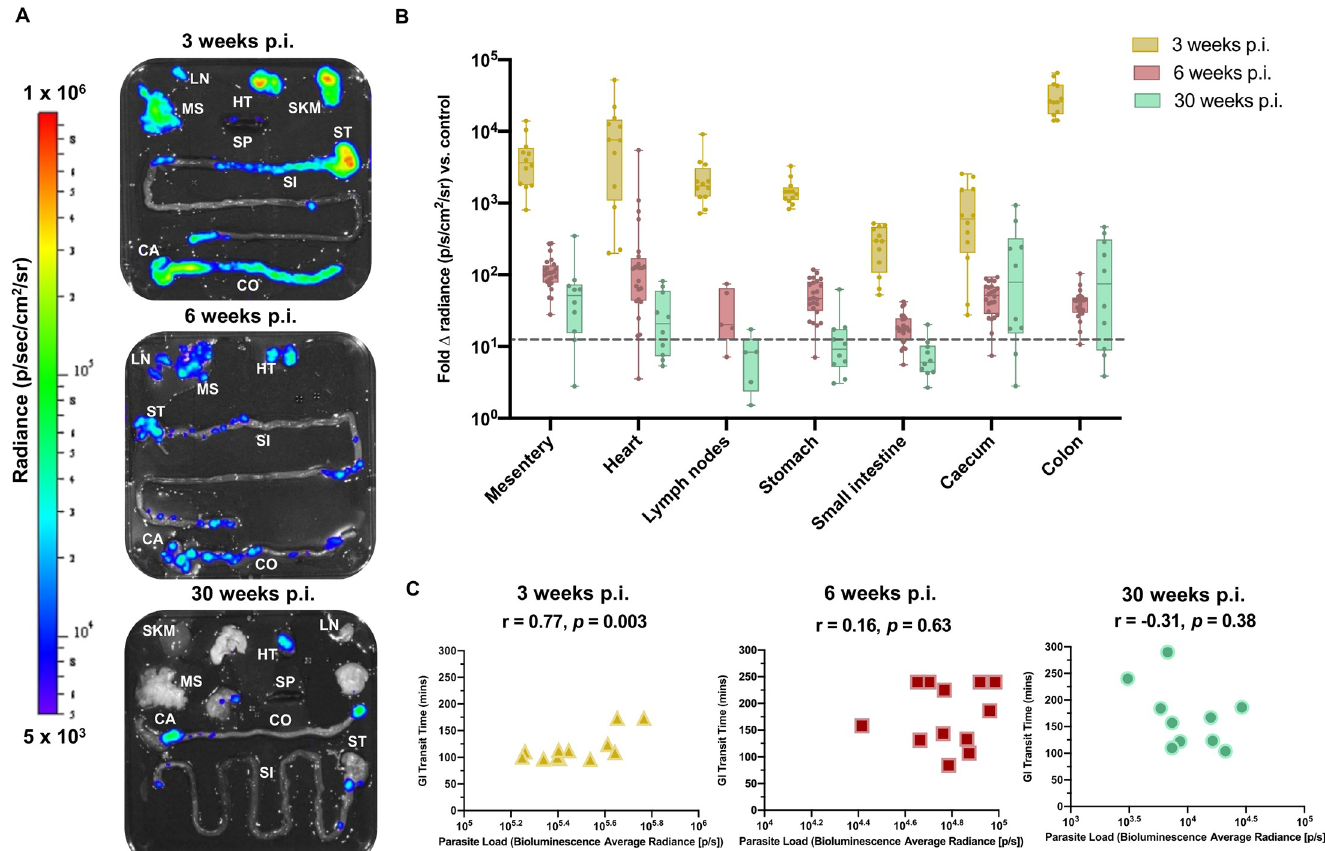
Fig 2. Tissue parasite distribution kinetics in TcI-JR-infected C3H/HeN mice. A. Representative images show parasite distribution in different organ tissue (lymph nodes—LN, gut mesenteric tissue—MS, heart—HT, spleen—SP, skeletal muscle—SKM, stomach—ST, small intestine—SI, caecum—CA and colon—CO) of a TcI-JR infected C3H mouse at 3, 6 and 30 weeks post-infection (p.i.) using ex vivo bioluminescence imaging. Overlaid log-scale pseudocolour heat maps are representative of bioluminescence intensity; the log-scale range is indicated in units of radiance. B. Box-plots show infection intensity of different organ tissue at 3 ( n = 12 per group), 6 ( n = 24 per group except n = 5 lymph nodes) and 30 ( n = 10 per group except n = 5 lymph nodes) weeks p.i. Data points are expressed as fold change in bioluminescence vs. na ï ve controls. Limit of detection is denoted as dashed line. The horizontal line within each box indicates median and the whiskers denotes minimum and maximum values of each dataset. C. Scatter plots show correlation between gastrointestinal transit time and end-point parasite densities expressed as the aggregate bioluminescence radiance of the GI tract regions at 3 ( n = 10), 6 ( n = 12) and 30 ( n = 10) weeks p.i.; r denotes Pearson’s correlation coefficient and p- value represents a measure of statistical